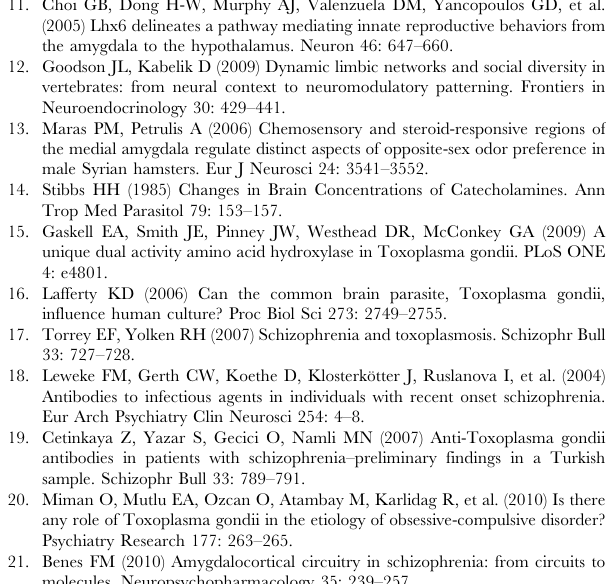
Figure S1 Toxoplasma Alters Volumes and c-Fos Ex- pression of Limbic Regions Involved in Processing Cat Odor. (A) Schematic diagram (adapted from Paxinos and Watson 2007) of coronal slices of rat brain showing areas of c-Fos and volume quantification. (B) Volumes of amygdalar and hypotha- lamic regions of interest in uninfected and Toxoplasma -infected animals. Coronal 40 um sections were taken throughout the whole region and 3-dimensional volumes were calculated via stereolog- ical analysis. (C) Digital camera lucida drawings of c-Fos signal in the lateral amygdala in uninfected (left) or infected (right) rats. (D) Digital camera lucida drawings of c-Fos signal in the medial amygdala in uninfected (left) or infected (right) rats. (E) c-Fos photomicrograph from which (C) is based. (F) c-Fos photomicro- graph from which (D) is based. Table S1 Density of c-Fos positive cells (mean 6